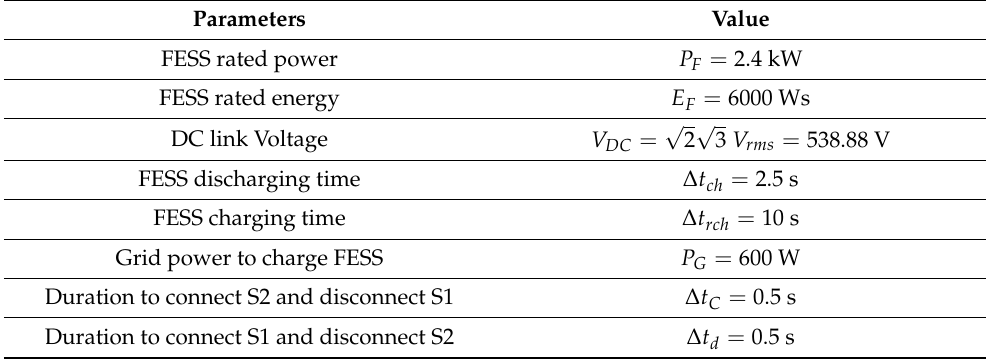
Table 7. FESS laboratory setup